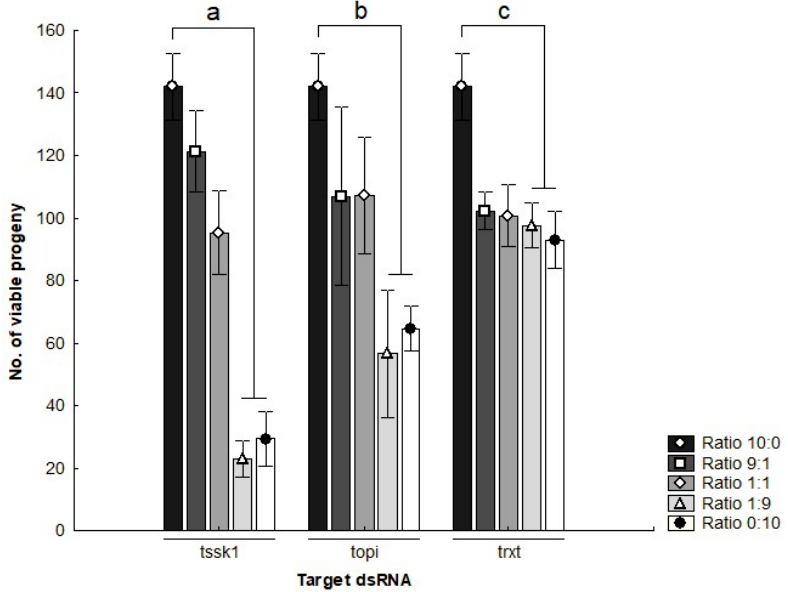
Figure 4. Number of viable progeny of Bactrocera tryoni produced in cages seeded with different ratios of dsRNA-treated males (Negative controls: gene-specific dsRNA treatments). Values represent the means (bars) and the 96% standard errors (whiskers) of three biological replicates; letters denote statistically significant differential responses relative to the control treatments, t -test ( p < 0.05).